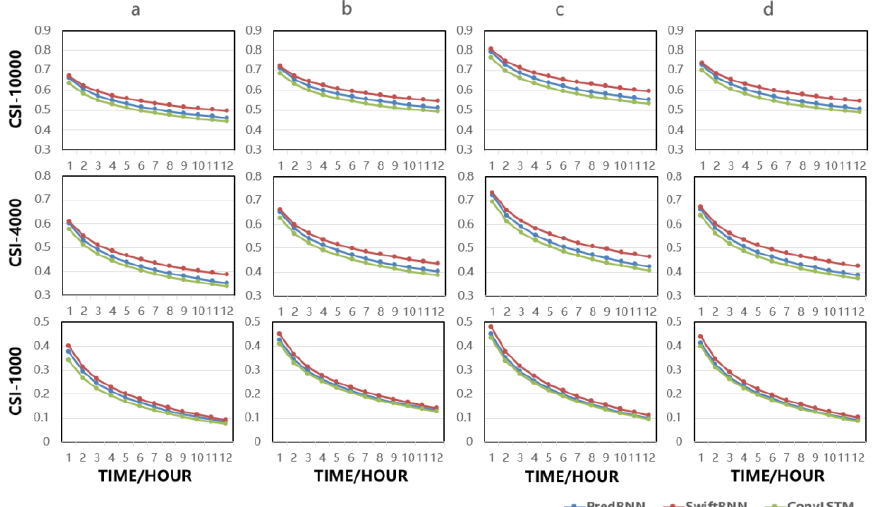
Figure 8. Prediction evaluation metric for visibility field map prediction in ( a ) January, ( b ) April, ( c ) July, and ( d ) October. Table 8. Model training